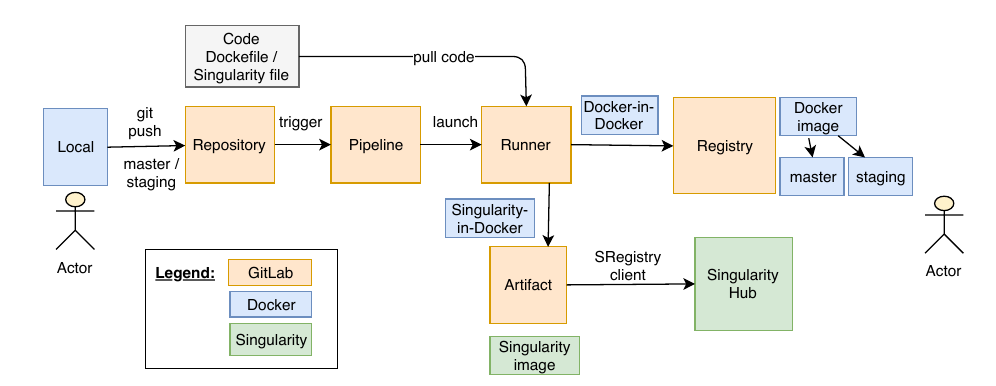
Figure 3. CI / CD with Singularity: a new commit triggers the build of a Singularity image that will be pushed on a Singularity